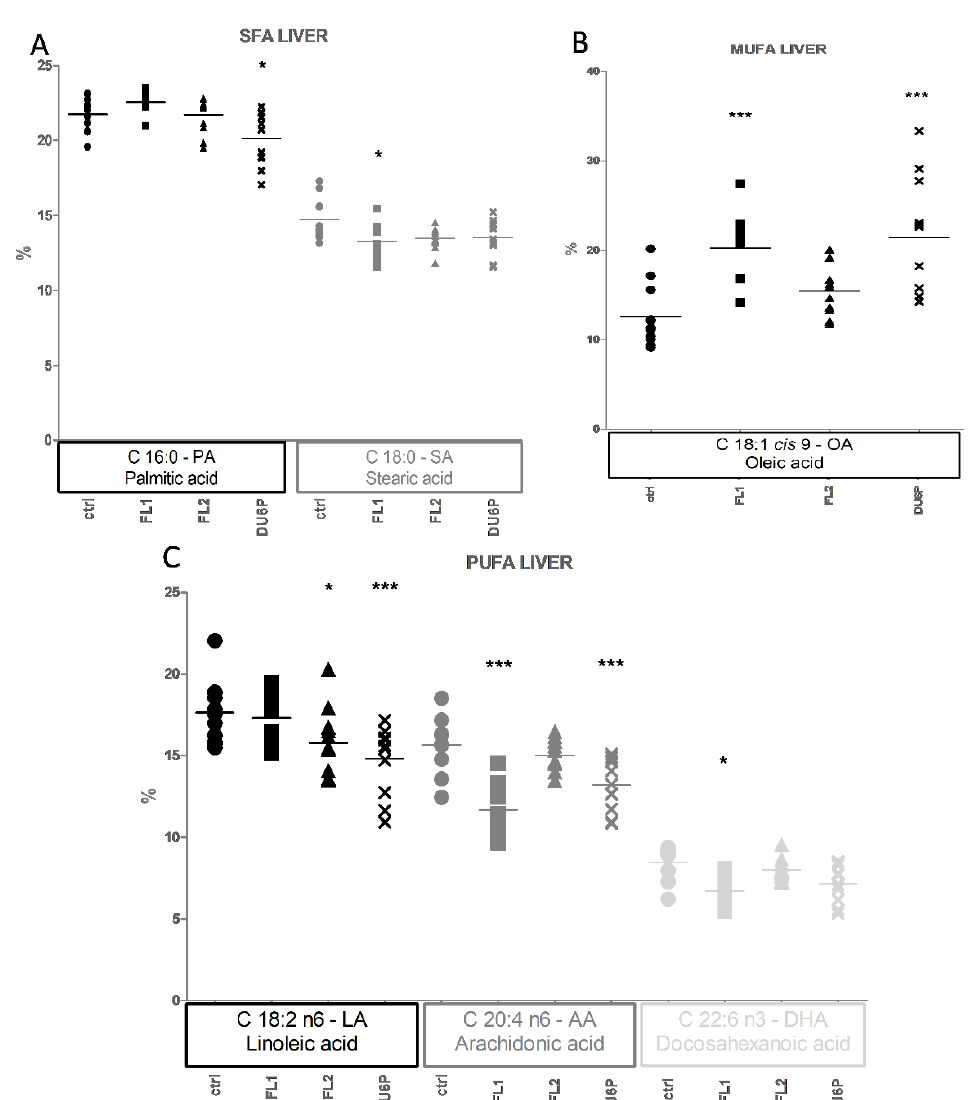
Figure 8. Liver composition of the most abundant SFAs (small symbols, A ), MUFAs (medium symbols, B ), and PUFAs (large symbols, C ) in control (circles), FL1 (squares), FL2 (triangles) and DU6P (crosses). Different FAs are represented using different tonalities. Data are illustrated as the mean ± SEM (standard error of the mean) and designated significant if p < 0.05 (Bonferroni posttest: * p < 0.05; *** p < 0.005, in comparison with control of the same group).